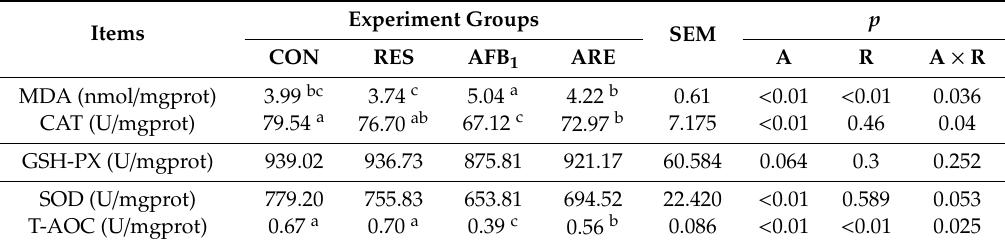
Table 4. The effect of dietary resveratrol supplementation on the hepatic redox status in AFB 1 - challenged mice.